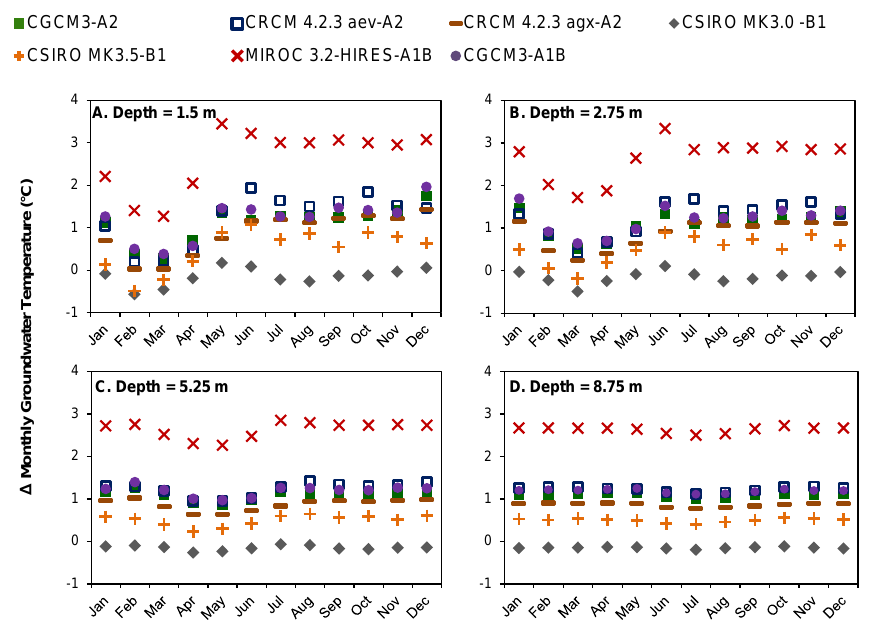
Fig. 12. Changes in monthly groundwater temperature produced by driving the GST-groundwater temperature transfer function with the projected GST data simulated for each of the seven climate scenarios (change=the simulated average monthly groundwater temperature for the 2046–2065 period minus the simulated average monthly groundwater temperature for the 1961–2000